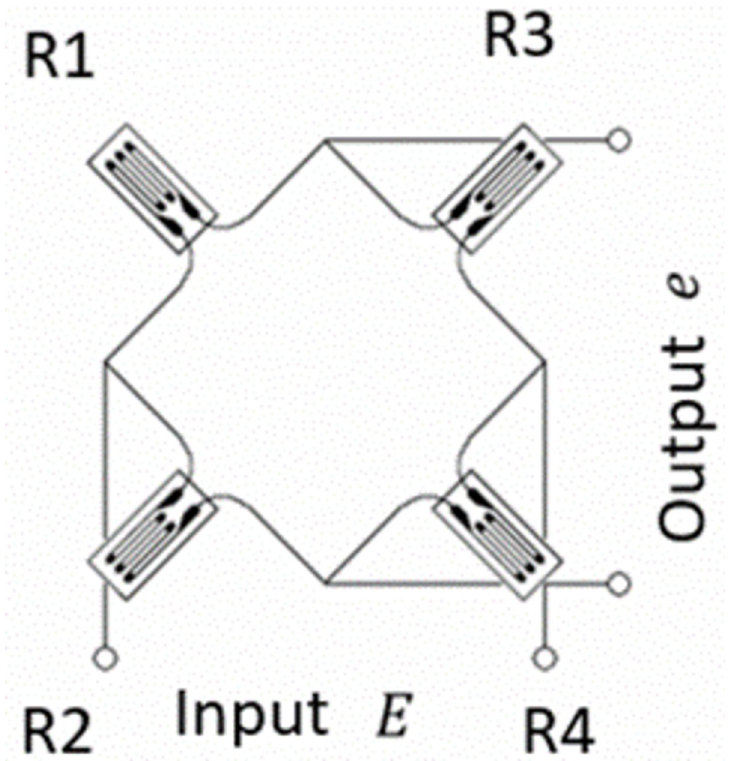
Fig 3. The wheatstone bridge arrangement of load-cell